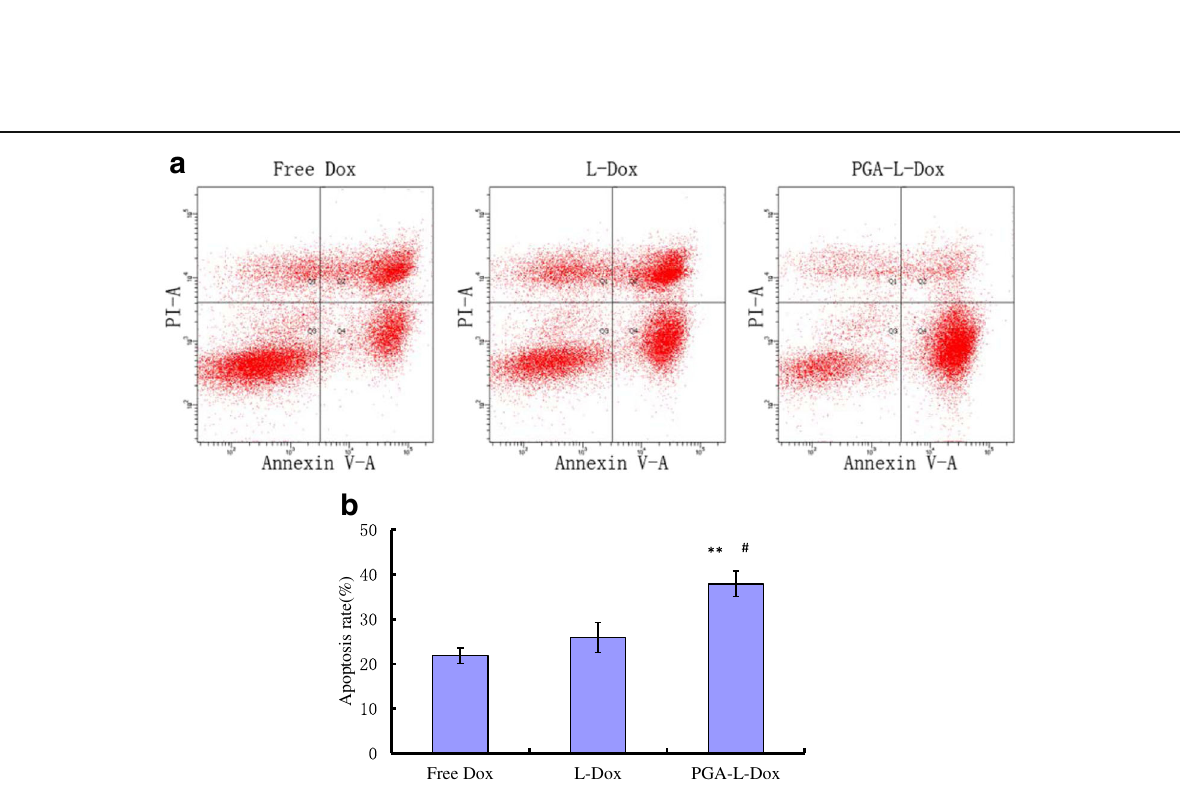
Fig. 4 The apoptosis rate of HepG2 cells via Flow cytometry assay after 48 h treatment with: free Dox, L-Dox, and PGA-L-Dox (containing Dox concentrations of 10 μ g/ml). The histogram shows the apoptosis rate (%) of HepG2 cells (n = 3). ** p < 0.01 vs. free Dox, # p < 0.05 vs.